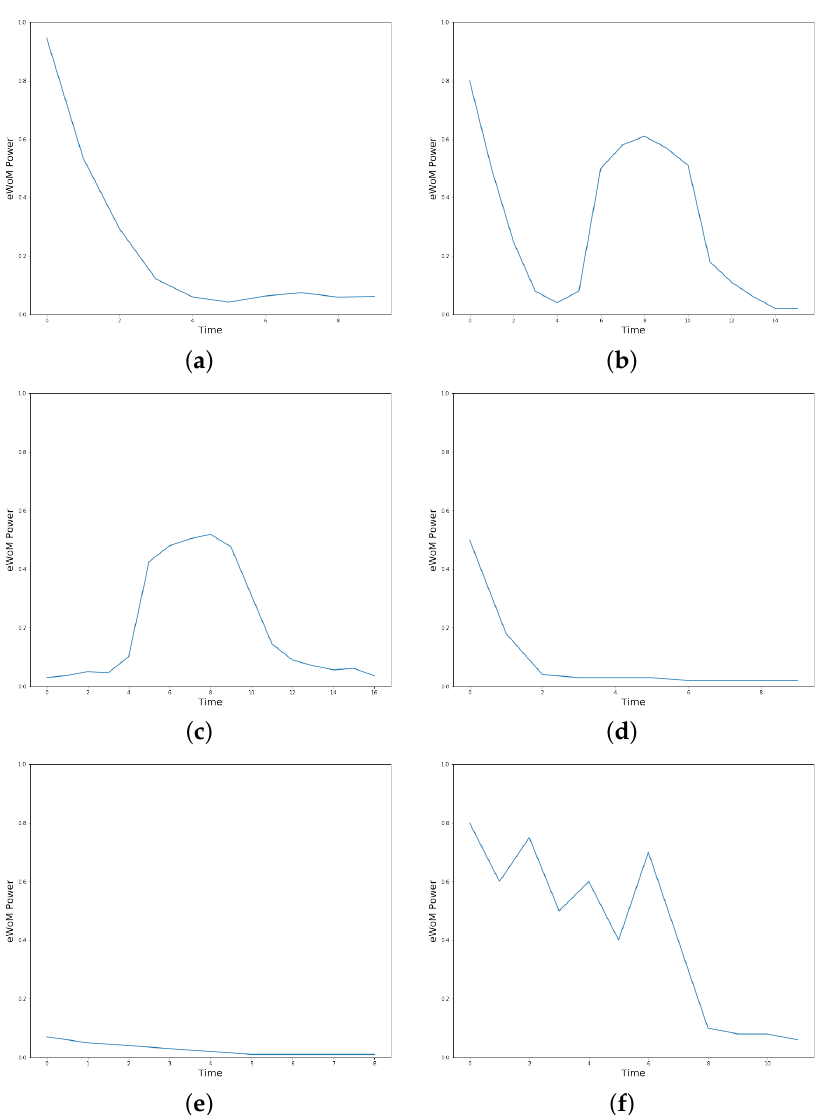
Figure 6. The six lifespan templates we determined: ( a ) explosive; ( b ) revived; ( c ) bell; ( d ) unlucky; ( e ) gray; ( f )